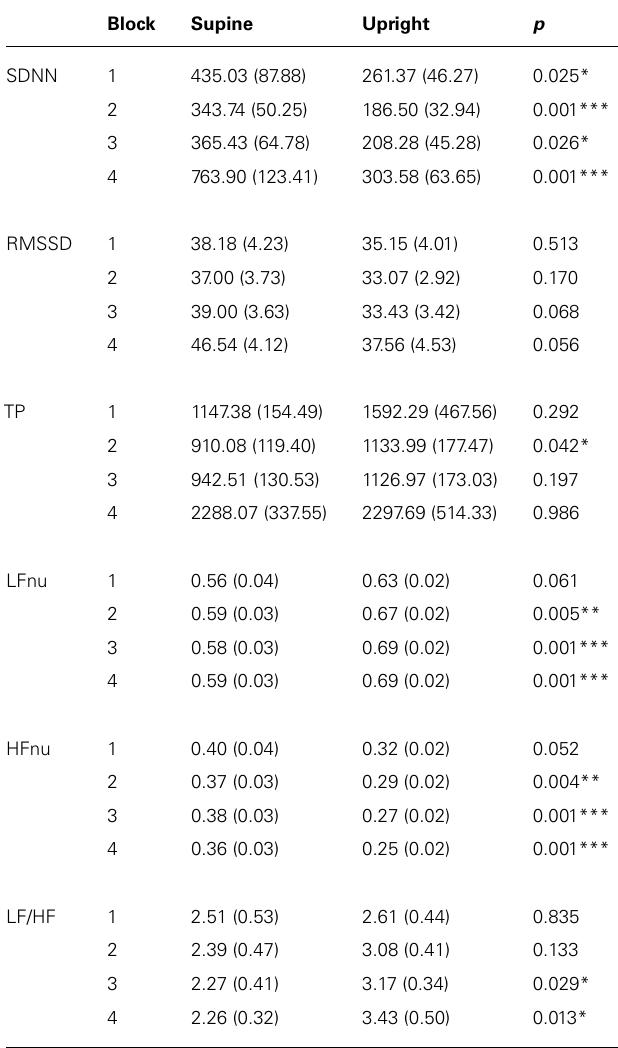
Table 2 | Means and standard errors of postures and time periods